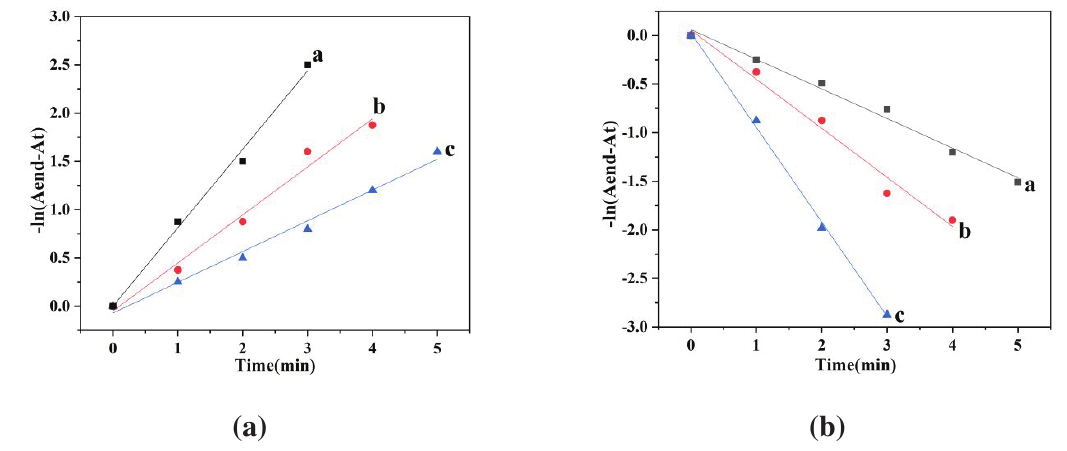
Figure 7: Kinetics of different conditions: (a) kinetics of: a – PWA/P (2VPco1MA), b – PWA/P (1VPco1MA), c – PWA/P (1VPco2MA), during coloration process; (b) kinetics of: a – PWA/P (2VPco1MA), b – PWA/P (1VPco1MA), c – PWA/P (1VPco2MA), during bleaching process.